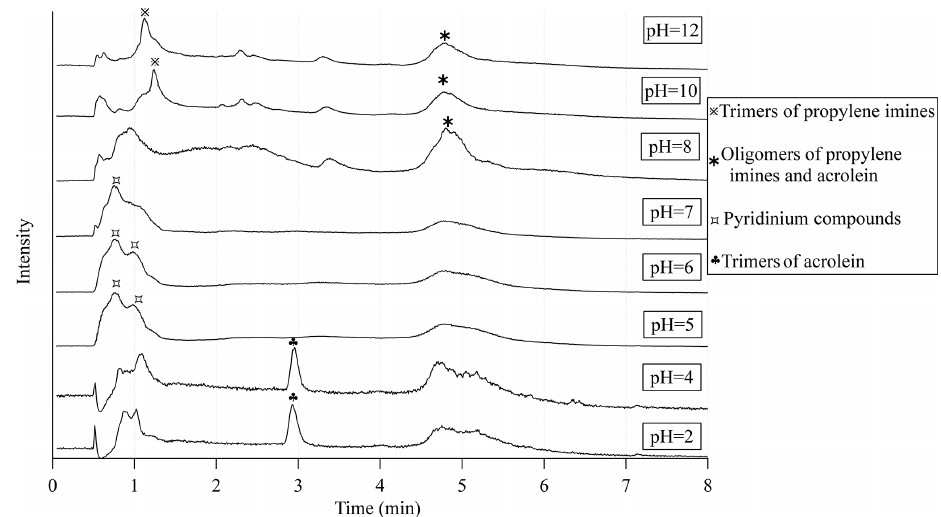
Figure 5. The total ion chromatographic traces of UPLC for samples in bulk solutions with different pH values. The main peaks are labeled with their corresponding species. The detailed mass spectra for these peaks are shown in Figs. 6, S3 and S4.